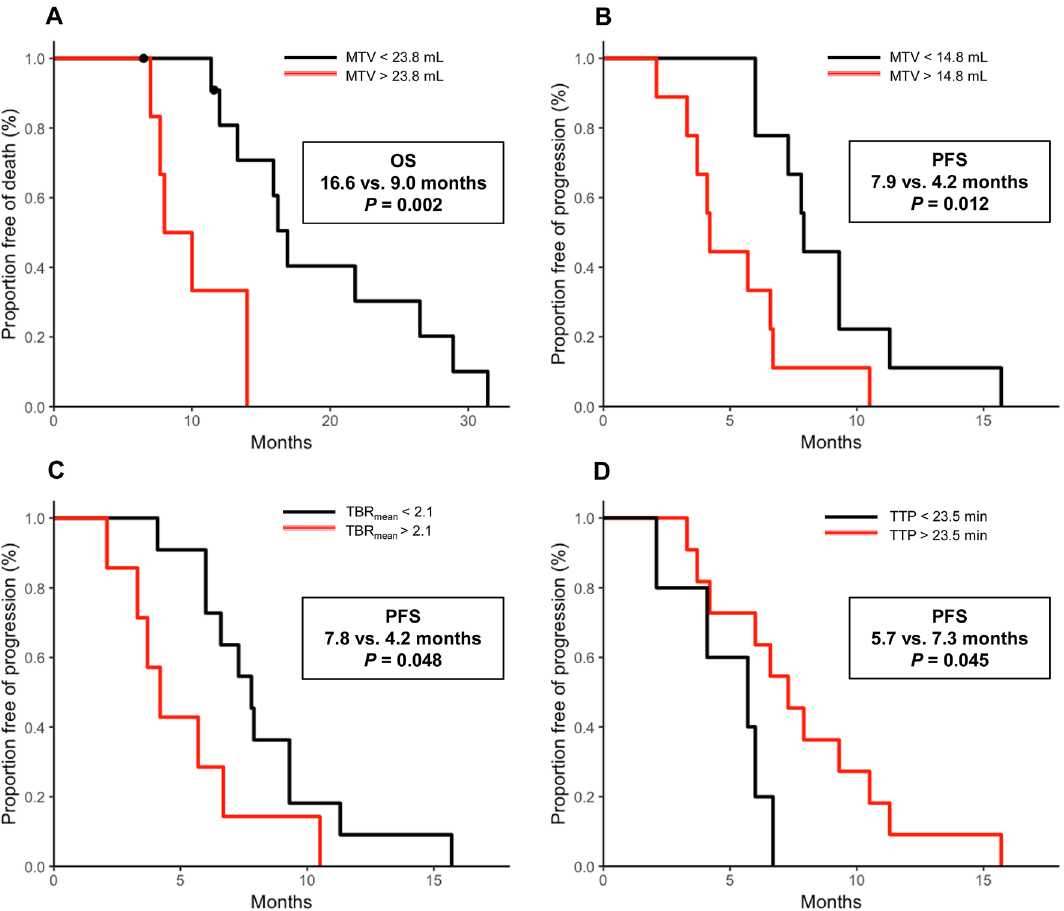
Figure 2. Kaplan–Meier curves for OS and PFS separated by the MTV ( A , B ), TBR mean ( C ), and TTP ( D ) within the patient group of newly diagnosed and IDH-wildtype astrocytic glioma.